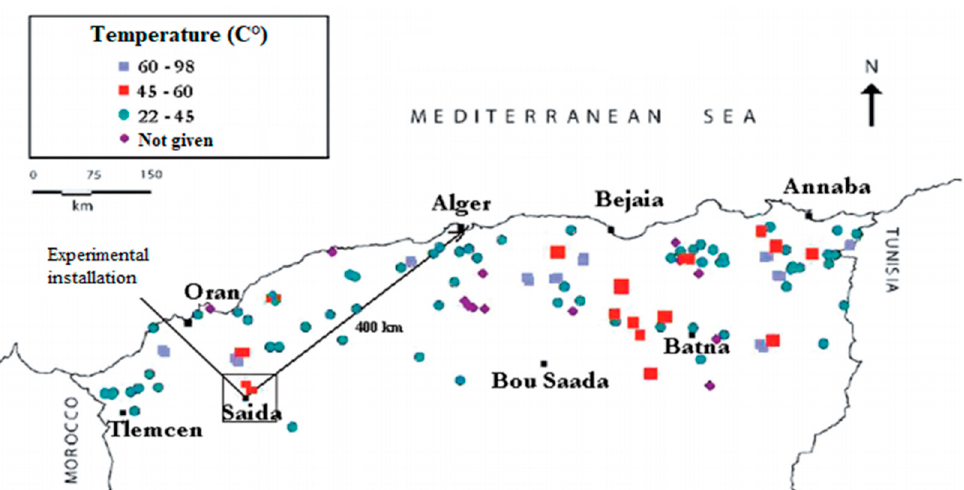
Figure 13. The geothermic chart in Algeria. Table 2. Thermal source locations in Algeria.